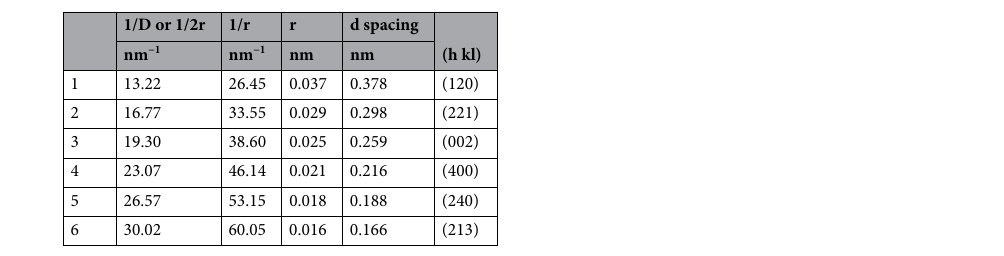
Table 4. Inter-planner spacing (d-spacing) for Sr 1−x Al 2 O 4 :Eu x (x = 0.05) phosphor (SAE 0.05 phosphor) from TEM SAED pattern.